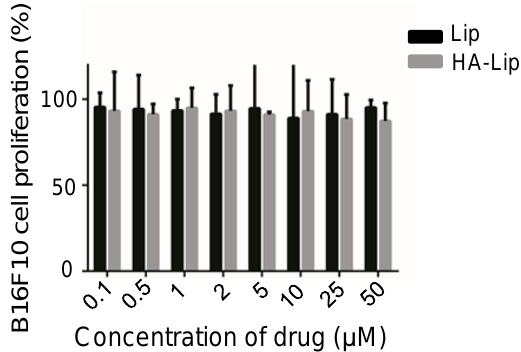
Figure 8. Cytotoxicity of the blank vector. ( n = 3).